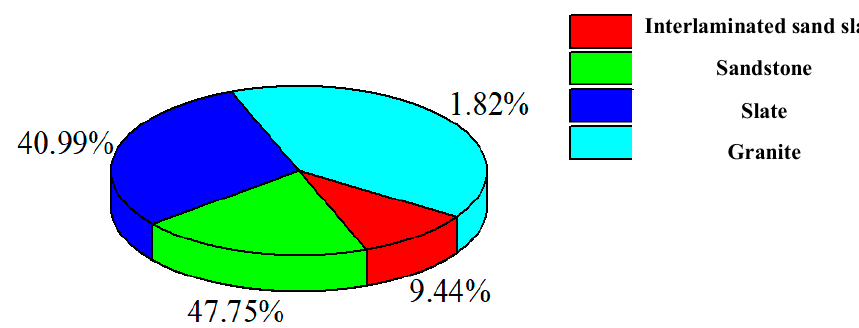
Figure 9. Lithology statistics of the slope adits on the left bank. The remote sensing image of the slope (Figure 10) is from the Sentinel-1A data. The monitoring cycle is 12 days, and the incidence angle of the remote sensing satellite is 39.18 ◦ . The monitoring period is from October 2014 to August 2019, a total of five years. Figure 11 illustrates the comprehensive cumulative deformation distribution of the slope.